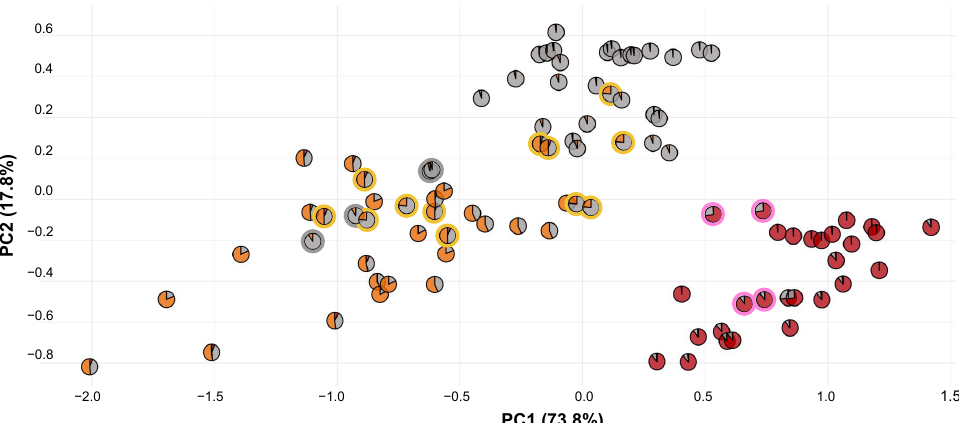
Figure 6. PCA of floral morphology for genetically-identified Platanthera species. Each sample point shows a pie chart generated based on population structure data for the individual sample or an average of the same samples in that particular site due to discordance between the samples analyzed genetically and those analyzed morphometrically. For clarity, we circled the putative hybrids (pink and yellow) and the P. blephariglottis samples that clustered with P. ciliaris morphometrically